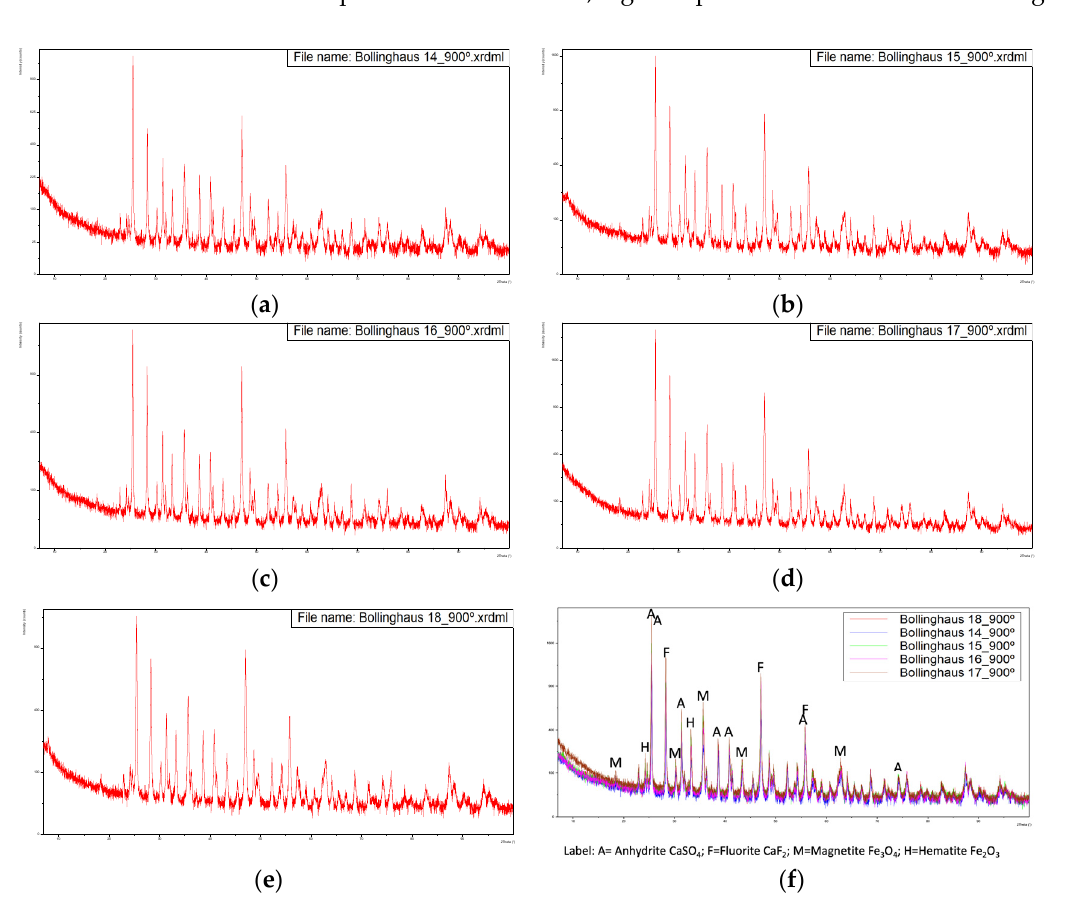
Table 3. Estimated compound compositions of the samples dried at 60 °C obtained by the Rietveld refinement method.